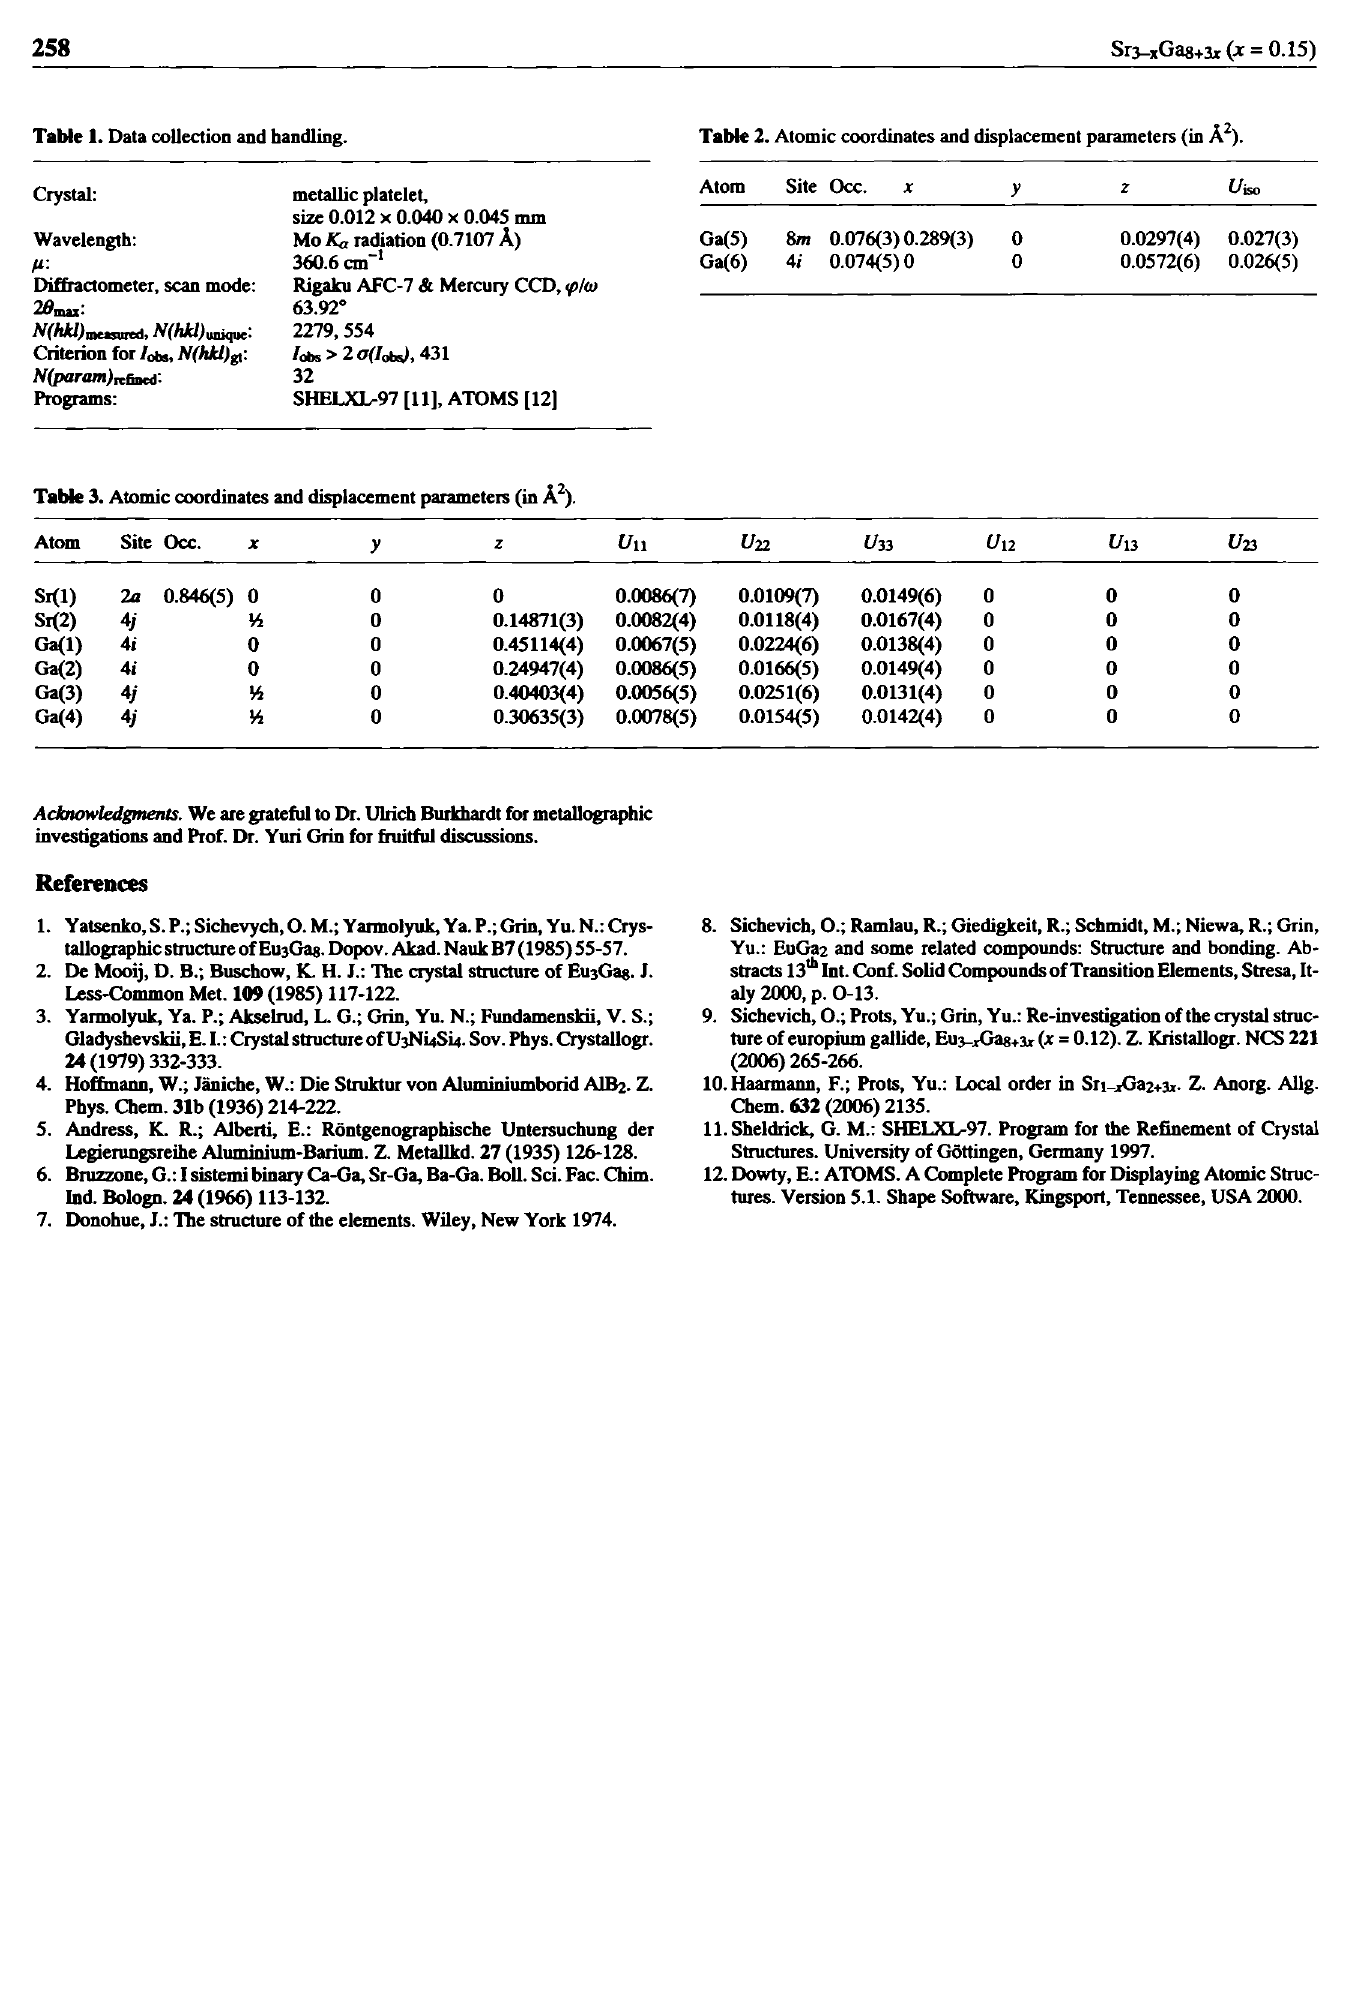
Table 1. Data collection and handling. Table 2. Atomic coordinates and displacement parameters (in A 2 ).